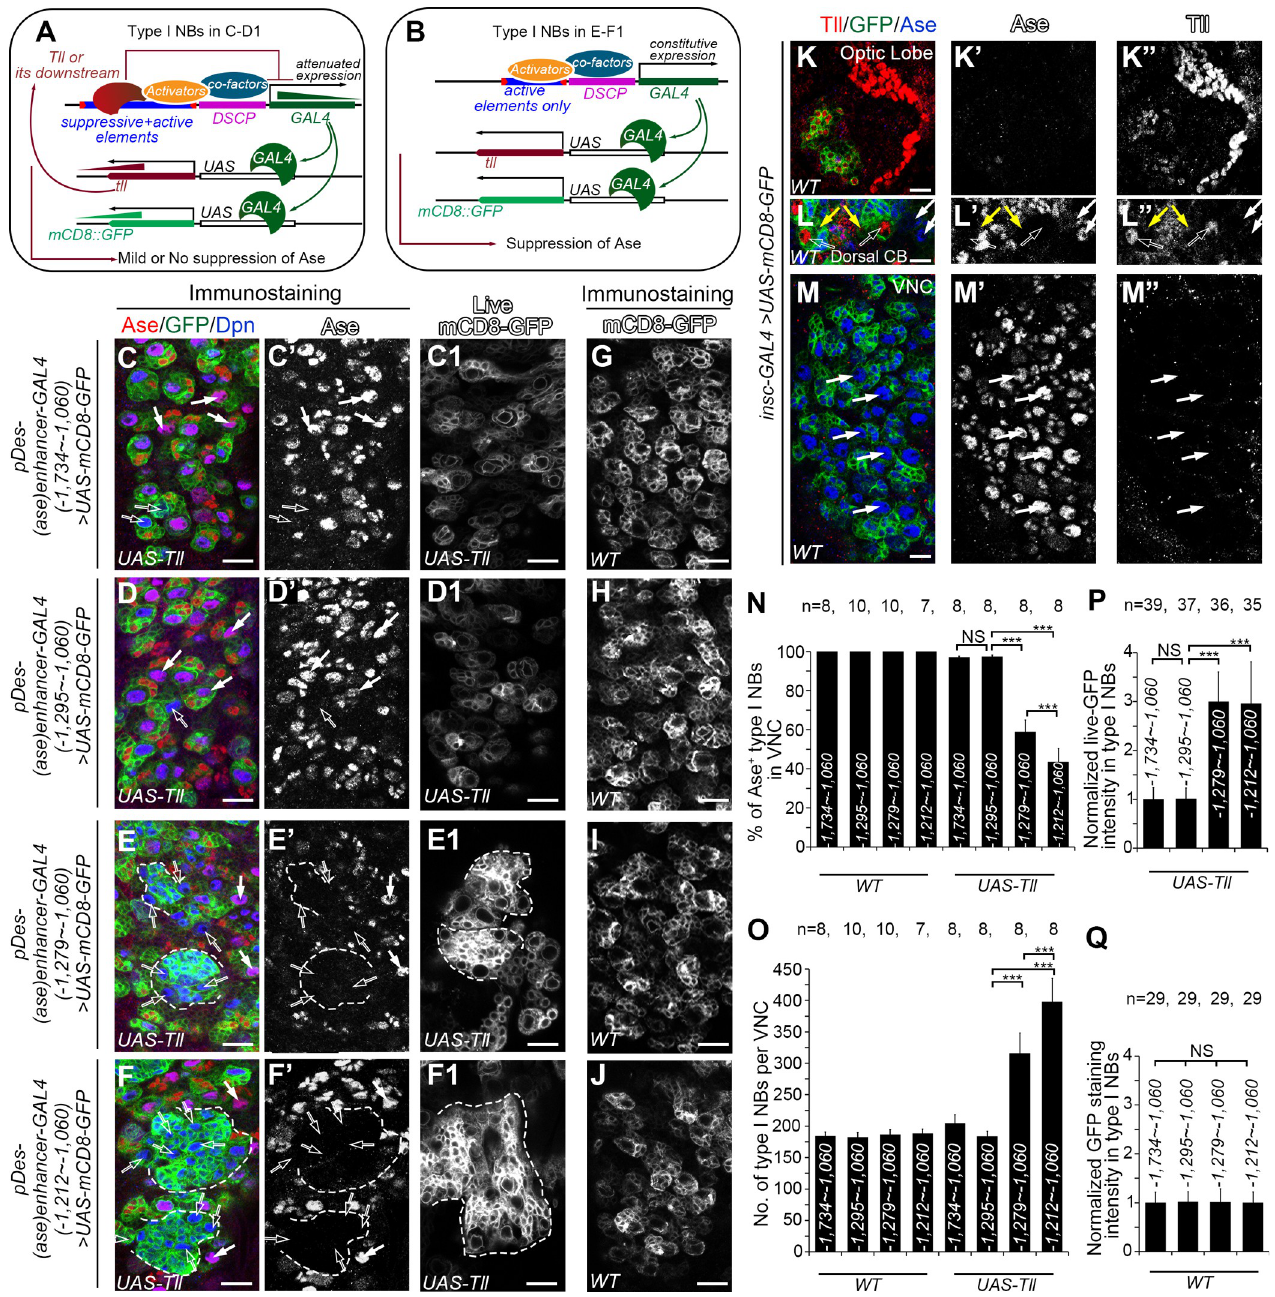
Fig 2. UAS-Tll expression driven by pDes-(ase)enhancer-GAL4 is compromised when the repressive element is included in the GAL4 promoter. In images (C-F) and (G-J) type I NBs are labeled with mCD8-GFP (in green) driven by pDes-(ase)enhancer-GAL4 drivers containing indicated ase enhancer fragments, and counterstained with anti-Ase (in red) or anti-Dpn (in blue) antibodies. In images (C1-F1), type I NBs are imaged live with the same settings for comparing mCD8-GFP expression levels. In images (L-M) both type I and type II NBs are labeled with mCD8-GFP (in green) driven by insc-GAL4 , and counterstained with anti-Tll (in red) or anti-Ase (in blue) antibodies under the same staining condition and imaging settings as those in the image (K). Scale bars equal 10 μ m. (A-B) Schematic diagrams show how the suppression of Ase by Tll is compromised [A, corresponding to (C-D1)] or maintained [B, corresponding to (E-F1)] in type I NBs. pDes-(ase)enhancer-GAL4 first drives the expression of Tll. The resulted exogenous Tll proteins bind to the repressive element in the pDes-(ase) enhancer-GAL4 driver and attenuates the subsequent GAL4 expression, leading to attenuated mCD8-GFP and Tll expression levels. The attenuated Tll expression is not adequate to suppress Ase expression (A). In contrast, pDes-(ase)enhancer-GAL4 drivers containing only the active elements constitutively drive GAL4 expression, which results in higher expression levels of mCD8-GFP and Tll and subsequent suppression of Ase by Tll (B). (C-D’) Expressing UAS-Tll driven by pDes-(ase)enhancer-GAL4 with the ase enhancer fragment -1,734 ~ -1,060 bps (C-C’) or -1,295 ~ -1,060 bps (D-D’), which contains both the repressive and active elements, leads to the suppression of Ase only in a few type I NBs (open arrows). The majority of type I NBs are still Ase + (white arrows).